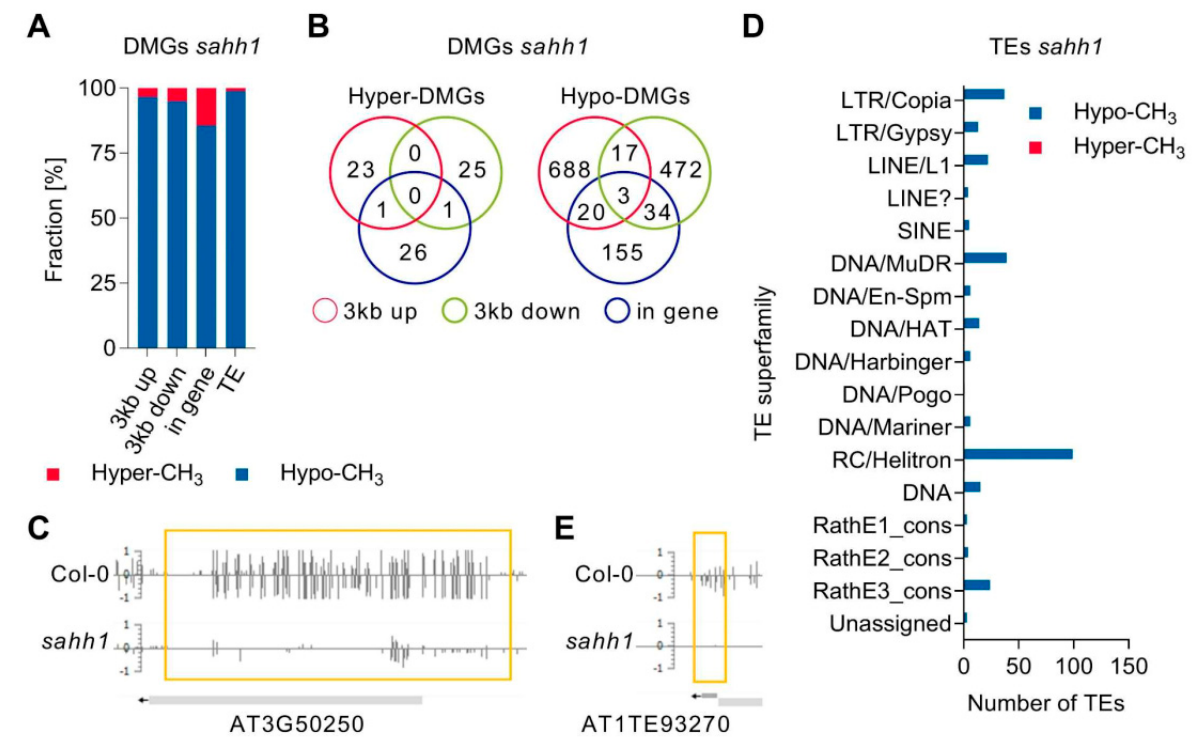
Figure 7. Knock-down of SAHH1 function results in an enrichment of hypomethylated DMGs and TEs. ( A ) Stacked bar plot showing the fraction of hyper- and hypo-DMGs and TEs with respect to DMRs found in their genic, 3kb up- or downstream region or TE coding region. ( B ) Venn diagram summarizing DMGs with DMRs in multiple genomic features (genic, 3kb up- and/or downstream flanking regions). ( C ) Snapshot of AT3G50250 in the EPIC-CoGE browser. ( D ) Distribution of differentially methylated TEs over TE superfamilies. ( E ) Snapshot of AT1TE93270 in the EPIC-CoGE browser. DNA methylation analyses were performed in duplicates, and average methylation ratios calculated in the CoGE browser are shown. TE classification according to www.arabidopsis.org (24 December 2018).